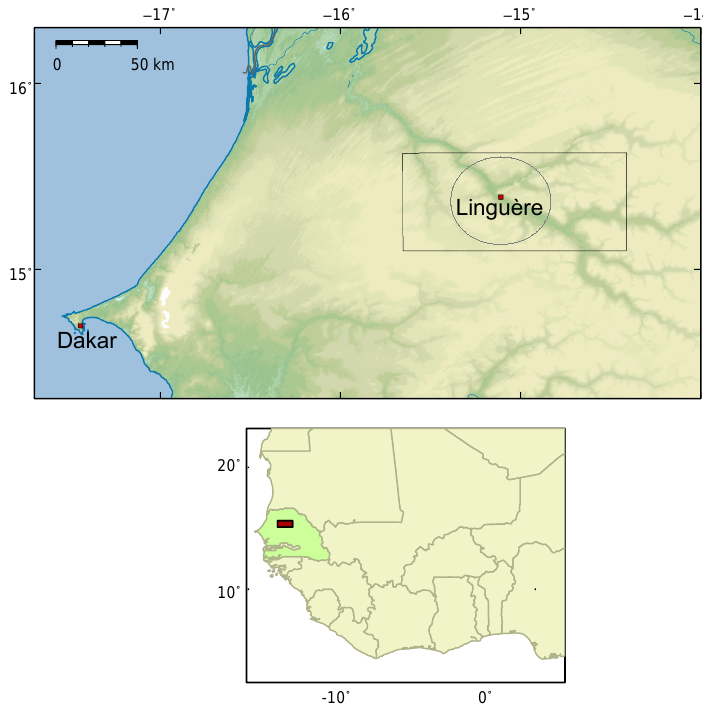
Figure 1. Position of the study area. The 84 training sites are located inside the circle around Linguère. For a detailed close up of the study area with high resolution imagery, we refer to Brandt et al.